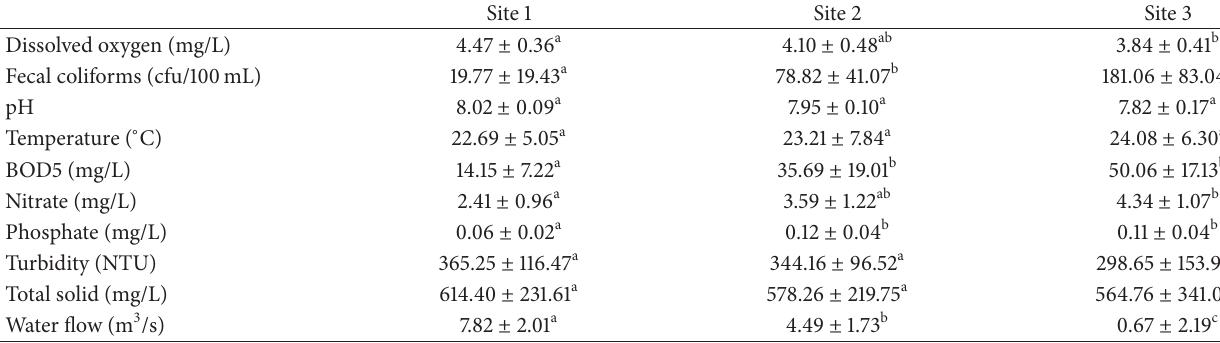
Table 1: Mean values ( ± standard deviation) of the physicochemical parameters.